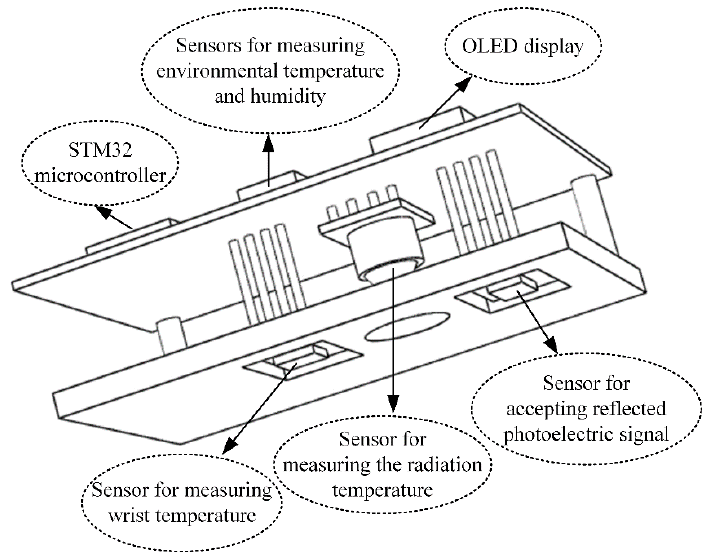
Figure 3. The 3D structure of the multisensor integrated detection probe.